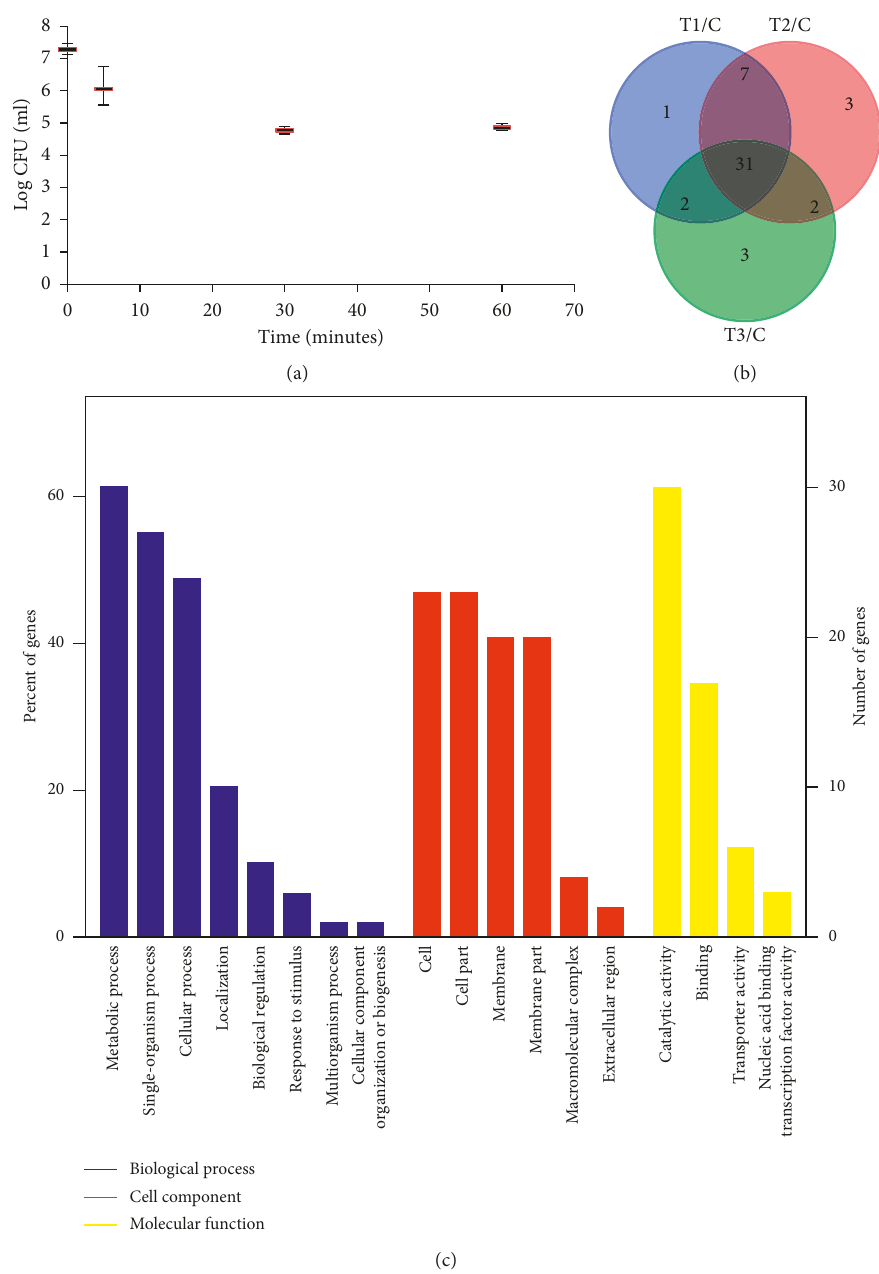
Figure 1: The inactivation of L. monocytogenes ATCC 19115 was estimated by culture-based enumeration in Tryptone Soya broth supplemented with 0.6% yeast extract (TSB-YE) with pH 3.5 (HCl as acidulant) and a w 0.90 (NaCl as humectant). (a) Inactivation curves were constructed by plotting log CFU/ml against the sampling time of 5min, 30min, and 1 hr at 25 ° C with an initial population of 7.28 logCFU/ml at time 0 in a time-course study (control). Colony-forming units were quantified on Brain-Heart Infusion Agar with 0.1% pyruvate (BHA-P). Bars represent the standard deviation of three independent samples. (b) Venn diagram showing proteins among the three iTRAQ datasets of control versus three time sampling points; T1, T2, and T3 represented 5 min, 30 min, and 1hr sampling time-point datasets. (c) GO enrichment analysis of the time-course study of differentially expressed proteins of L. monocytogenes ATCC 19115 due to environmental stresses of low pH 3.5 and high water activity of a w